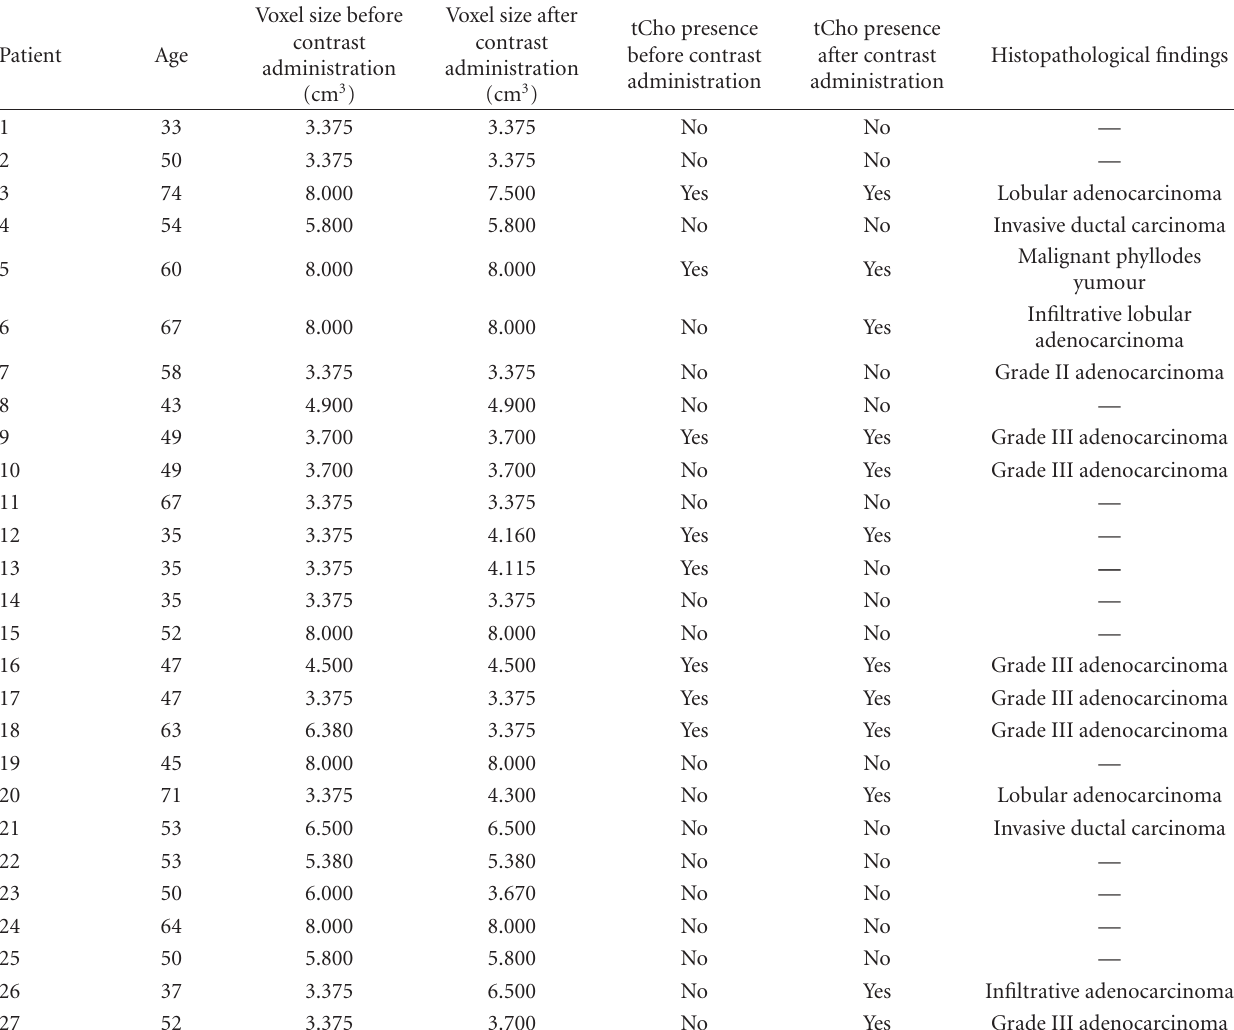
Table 1: Patient demographics, voxel size, 1H-MRS Choline presence, and histology results. Dash (—) indicates benign lesions.